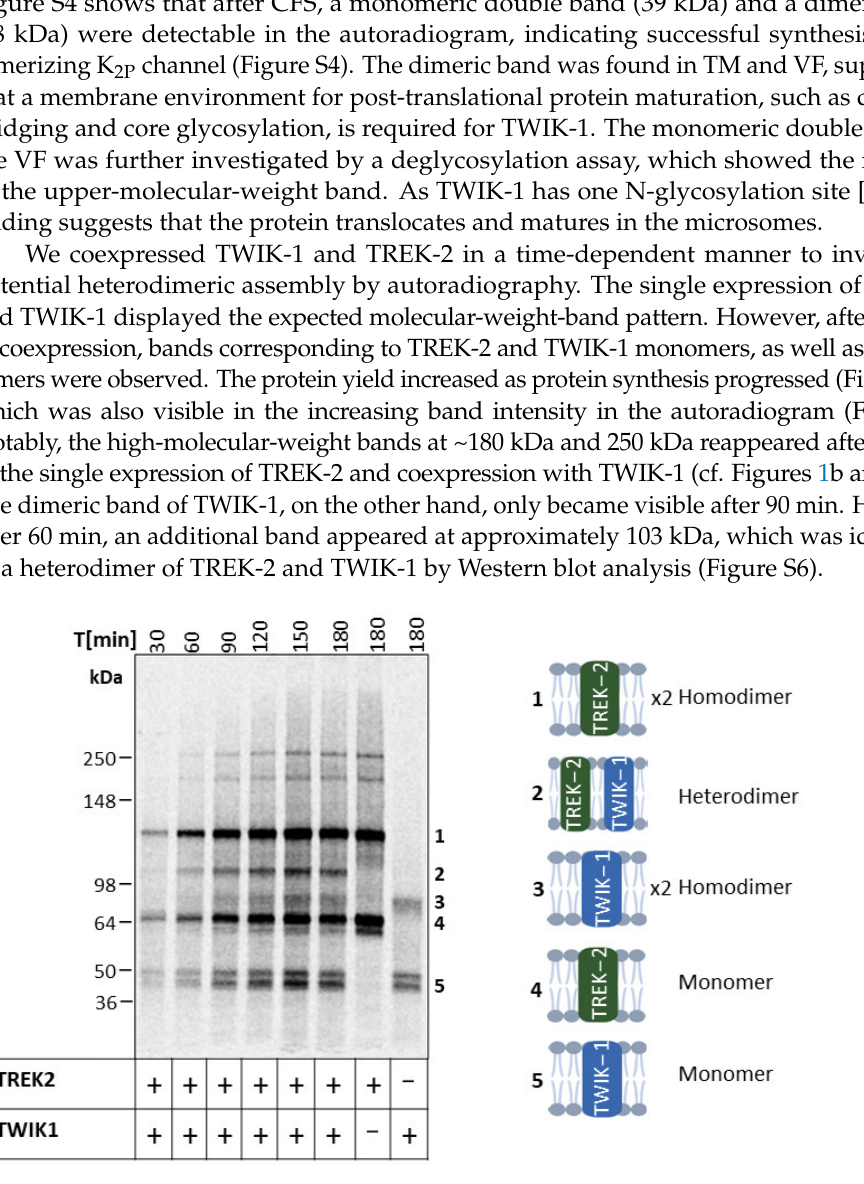
Figure 4. Heterodimerization of TWIK-1 and TREK-2 in cell-free synthesis. Individually and coex- pressed subunits of TREK-2 and TWIK-1 in Sf 21 lysate. Autoradiogram depicting 14 C-labeled pro- tein bands after synthesis of vesicular fractions (SDS-PAGE 4–12% Tris-Glycine).